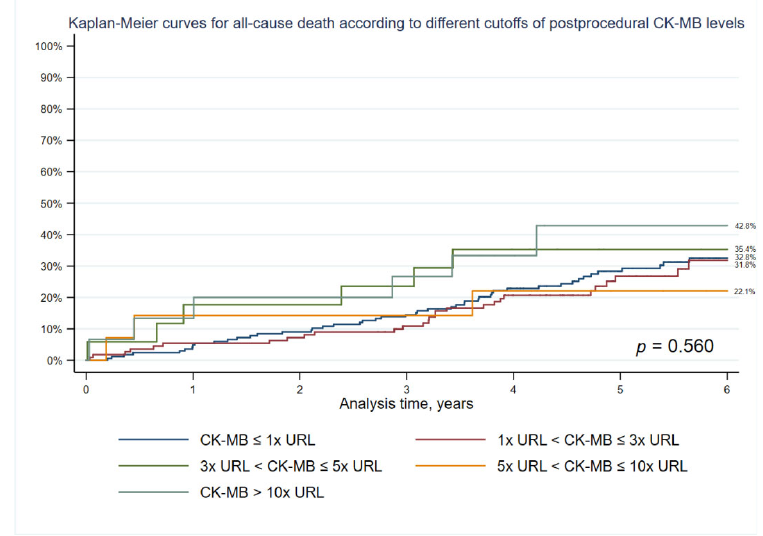
Figure 5. Kaplan-Meier curves for all-cause mortality according to different cutoffs of postprocedural CK-MB mass levels.